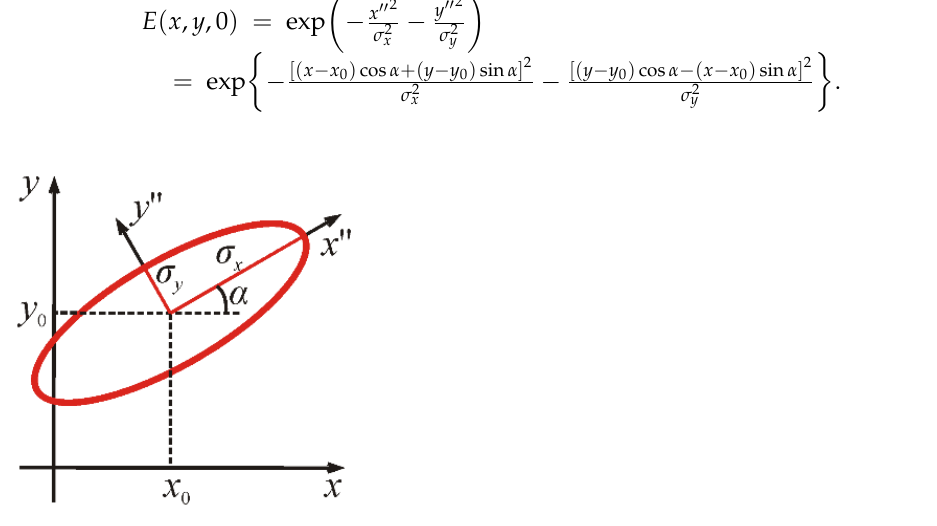
Figure 2. Geometric parameters of an elliptic light spot.